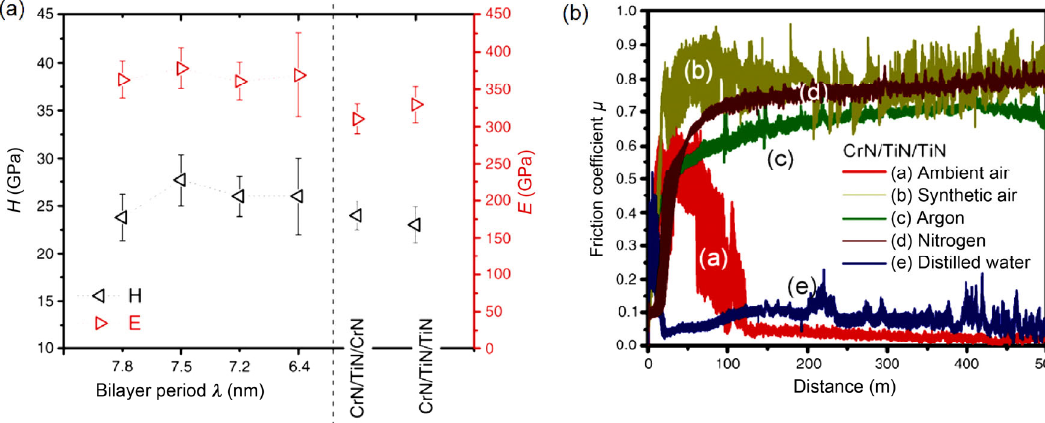
Fig. 5 (a) Hardness ( H ) and Young’s modulus ( E ) of multilayer coatings with respect to bilayer thickness (right side of the dash-line: multilayers with additional CrN and TiN layer deposited by HIPIMS) and (b) COF of coatings obtained in different atmospheres. Reprinted from Ref. [35], with permission from